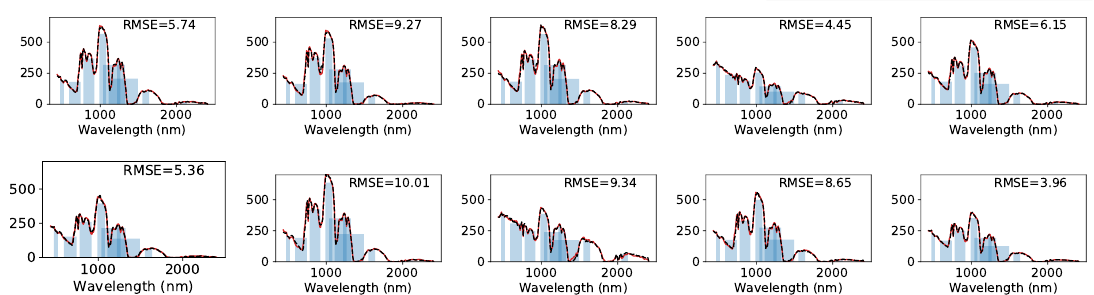
Figure 10. Examples of Hyperion spectra (satellite images dataset) reconstructions using learned bands (randomly selected from testing set). RMSE between the original and the reconstructed spectrum is measured in Wm − 2 sr − 1 nm − 1